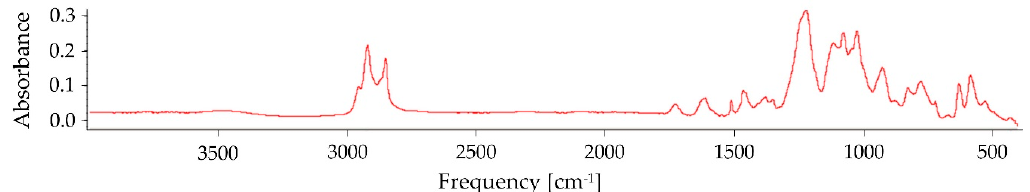
Figure 1. FTIR spectra of foaming agent (stearyl dimethylethylammonium methosulfate).